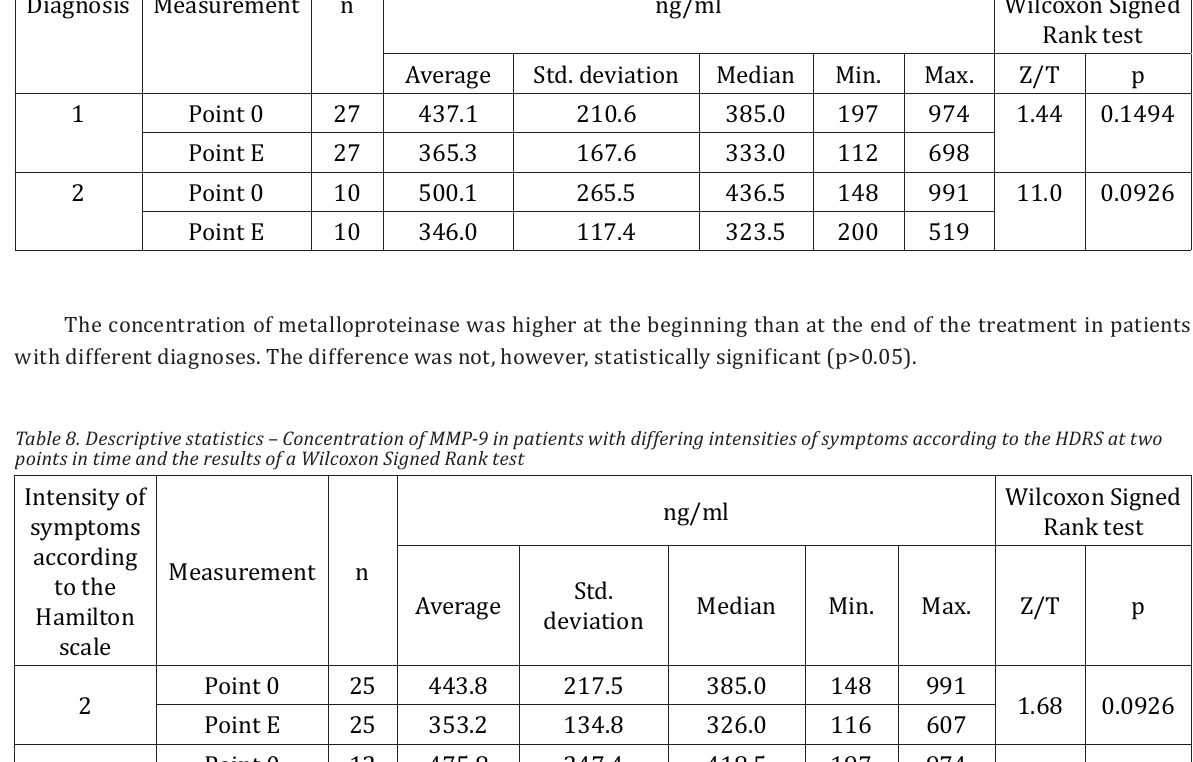
Diagnosis Measurement